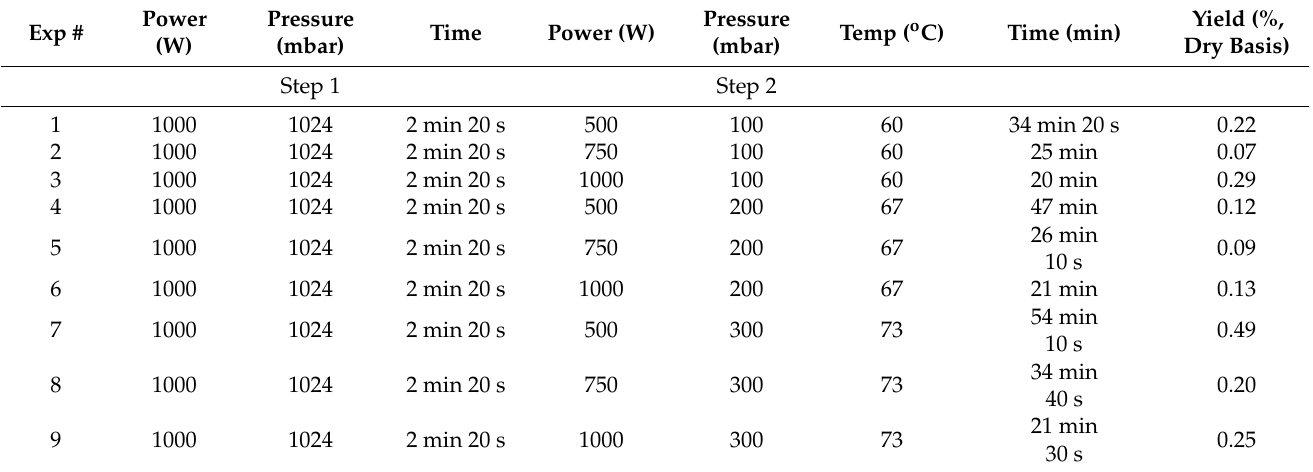
Table 2. Influence of experimental parameters on oil